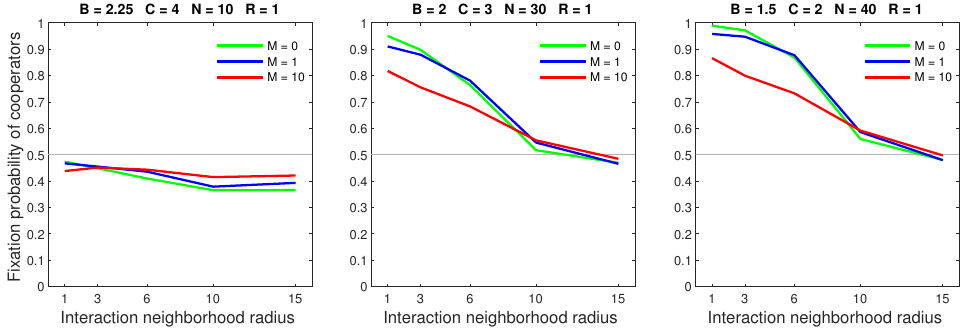
Figure 10. In the almost deterministic dispersal model, increasing the mobility rate is detrimental to cooperators in dense